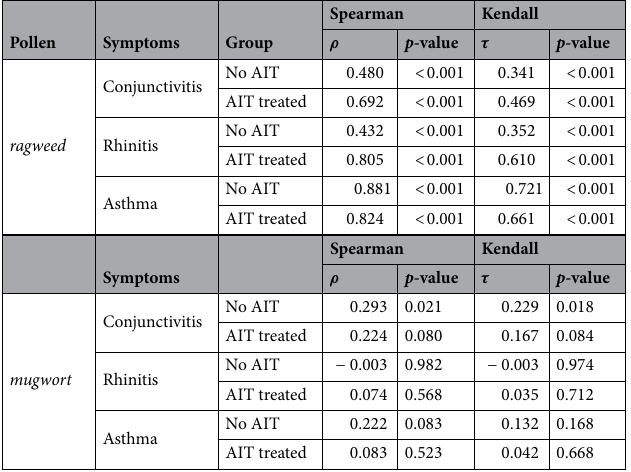
Table 4. Results of the correlation tests between the number of symptoms and pollen concentration: values of Spearman’s ( ρ ) and Kendall’s ( τ ) rank correlation coefficients and their significance.